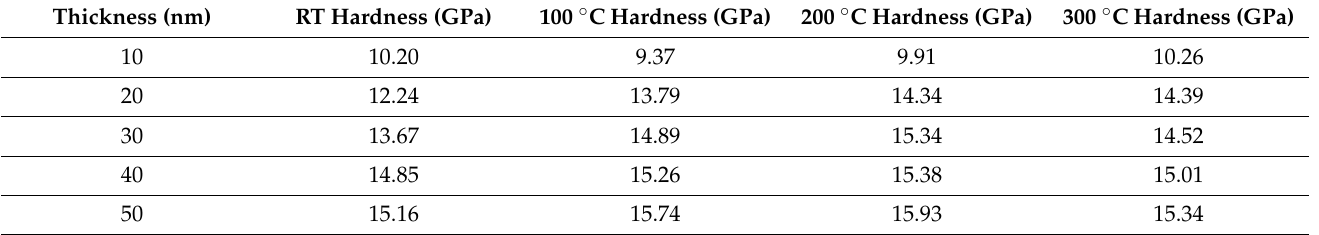
Table 2. Hardness of CoFeYb films.